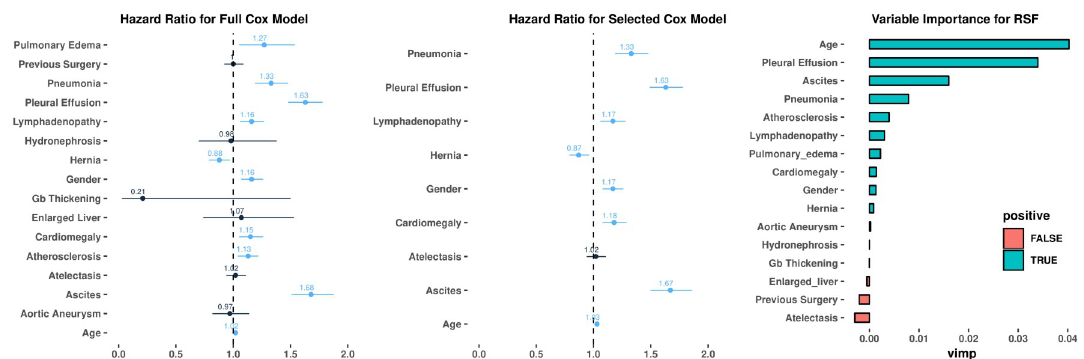
Fig 4. Correlation between radiographic findings and all-cause mortality. (A-B): Forest plot for the Cox model with all 14 variables and selected 9 variables. Numbers represent hazard ratios. The range of lines indicates 95% confidence intervals. Color blue implies significant variables with p < 0.05. (C) Variable importance plot of the Random Survival Forest model. Large positive values indicate the dependency of the outcome to get high predictive power. Values closer to zero represent a lower contribution to improved predictive accuracy. Negative numbers indicate the predictive accuracy would improve when the variables were unspecified.